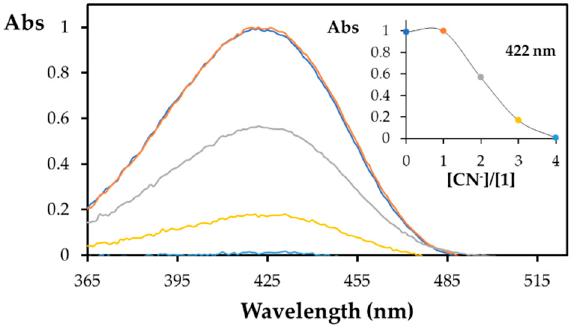
Figure 4. Spectrophotometric titration of dicyanovinyl derivative 1 with the addition of increasing amounts of CN − in ACN/ H 2 O (8:2). The inset represents the normalized absorbance at 422 nm ([1] = 8.0 × 10 − 6 M).